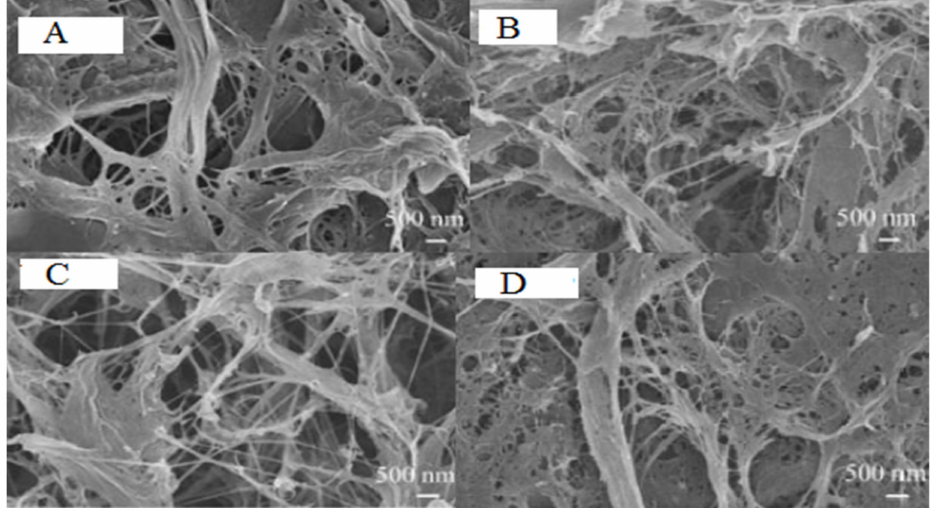
Figure 2. Field emission electron scanning microscopy (FESEM) images of CNFs, prepared from poplar CTMP ( A ), unbleached Pine kraft pulp ( B ), bleached Pine kraft pulp ( C ), and bleached Acacia kraft pulp ( D ) [71]. All permissions obtained through Rights Link ®